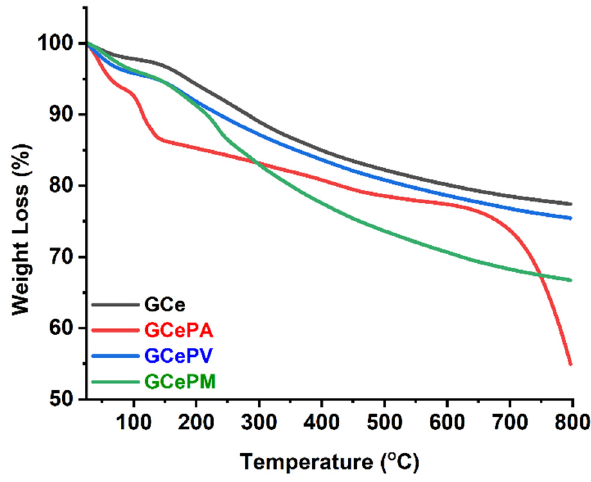
Figure 9. TGA results for the monolithic rGO composites with CeO 2 and CeO 2 @polymers. Out of the TGA results, it can be seen that the composites with polymers had lower thermal stability than the samples with only CeO 2 , as was expected. All samples could maintain more than 80% of their mass until 350 °C. The samples with PAA and PMETAC degraded more, and in the end, they lost more of their mass (Figure 9). At 800 °C, the GCe lost 22.6%, the GCePN lost 24.6%, the GCePM lost 33.7% and the GCePA lost the most of its mass (45.1%). Small mass losses could be seen at around 100 °C, which were attributed to the water absorbed in the monolithic mass. The sample without any polymer just lost 2.2%, while the monoliths with PMETAC and PNVCL lost similar amounts (3.8% and 4.2%, respectively). Again, the higher water amount lost was for the sample with PAA, since it is quite hydrophilic, and this percentage was 7.4%, as can be found in Figure 9. In general, the sample with PNVCL was always more stable thermally in all the temperature ranges than the other two polymers. For the case of monoliths with PAA and PMETAC, from room temperature to 300 °C, the GCePM is more stable than the GCePA. Then, there was a shift, and the GCePA is more stable thermally and stabilized until there was a big drop in its mass at 750 °C. Finally, after the shift at 750 °C, the GCePM showed less mass lost at the end of the TGA. 3.2.3. N 2 Adsorption-Desorption To better understand the structural properties and porosity of these materials, experiments of N2 adsorption-desorption were conducted. In Table 3, these results can be found. Table 3. Textural properties of the monoliths with different polymers. Samples